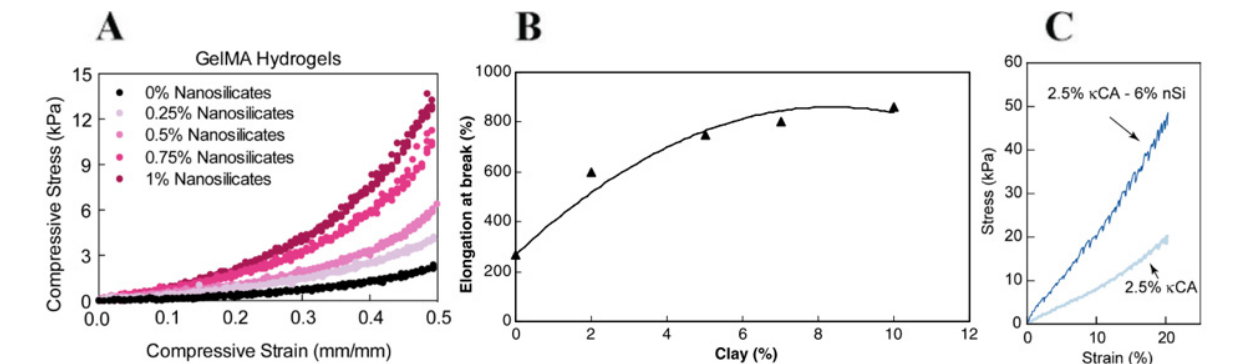
Figure 12 . ( A ) Uniaxial compression test of GelMA hydrogels with nanosilicates’ addition. (Adapted with permission from [66]. Copyright 2018, Elsevier). ( B ) Elongation at break of polyvinyl alcohol (PVA) and organoclay nanocomposite hydrogel films. (Adapted with permission from [52]. Copyright 2017, Elsevier). ( C ) Uniaxial compression test of cross-linked 3D structures printed from κ CA − nanosilicate bioinks. (Adapted with permission from [63]. Copyright 2017, American Chemical Society).